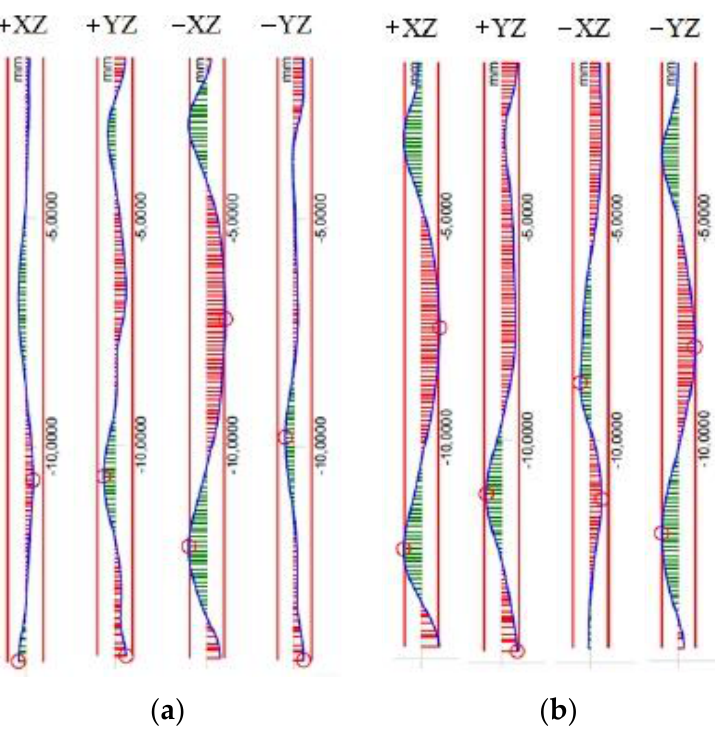
Figure 20. Straightness deviations ( a ) constant Z strategy; ( b ) circular pocket strategy.